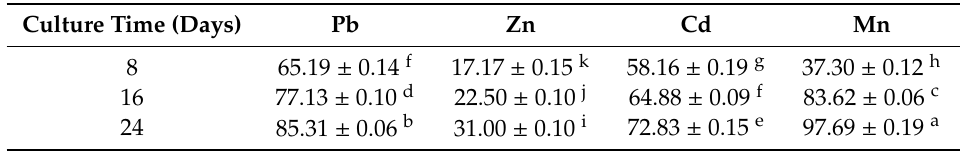
Table 3. Removal e ffi ciencies of Pb, Zn, Cd, and Mn from karst water by Eichhornia crassipes in the single heavy metal system (%).